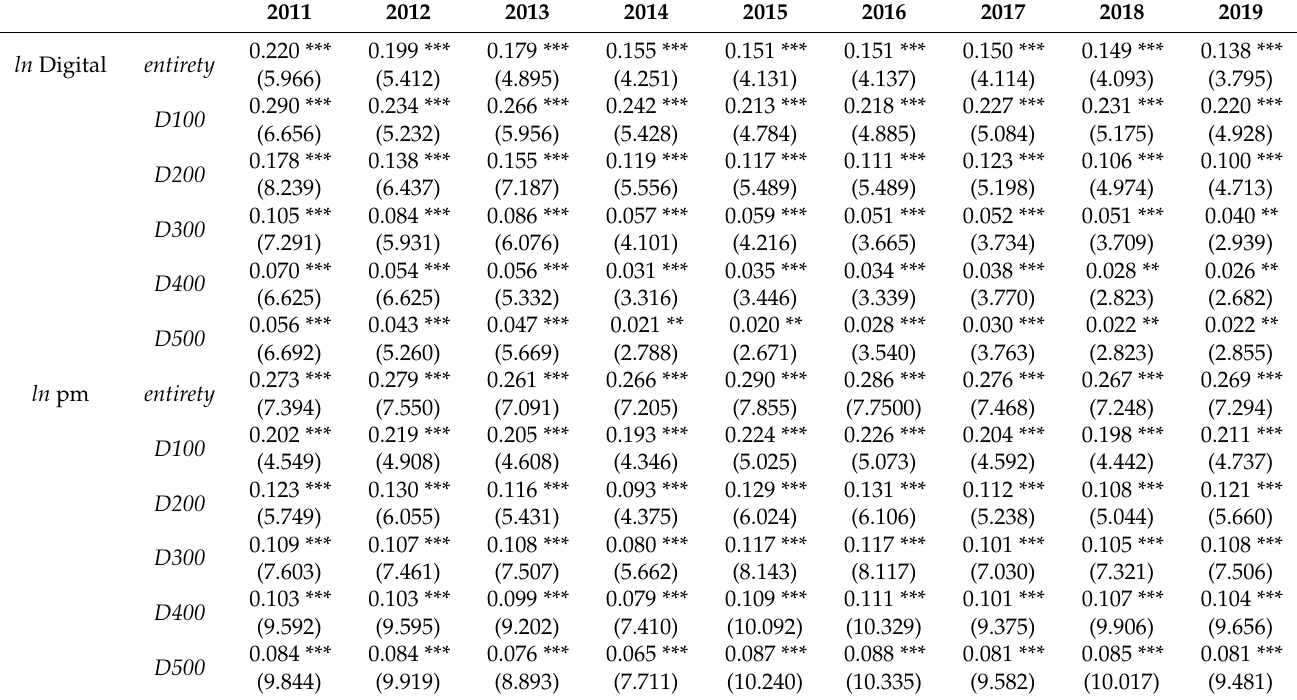
Table 3. Moran’s I index of the digital economy and PM 2.5 emissions at different spatial